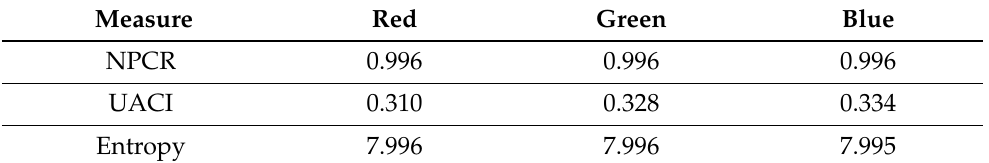
Table 3. Results of NPCR, UACI, and Entropy tests for a RGB image after permutation and diffusion. Measure Red Green Blue